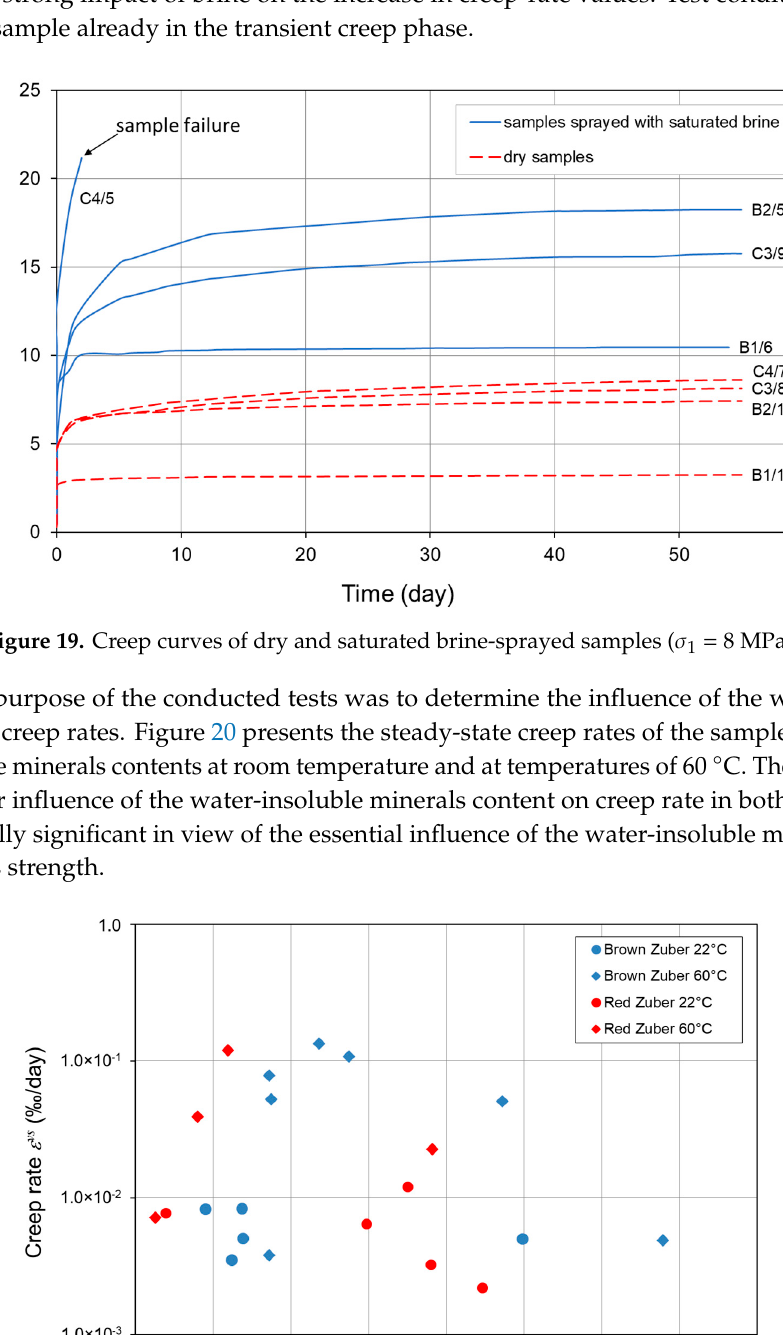
Figure 18. Long-term creep curves of the Brown Zuber unit samples at changing stress and temperature conditions (according to [58]).